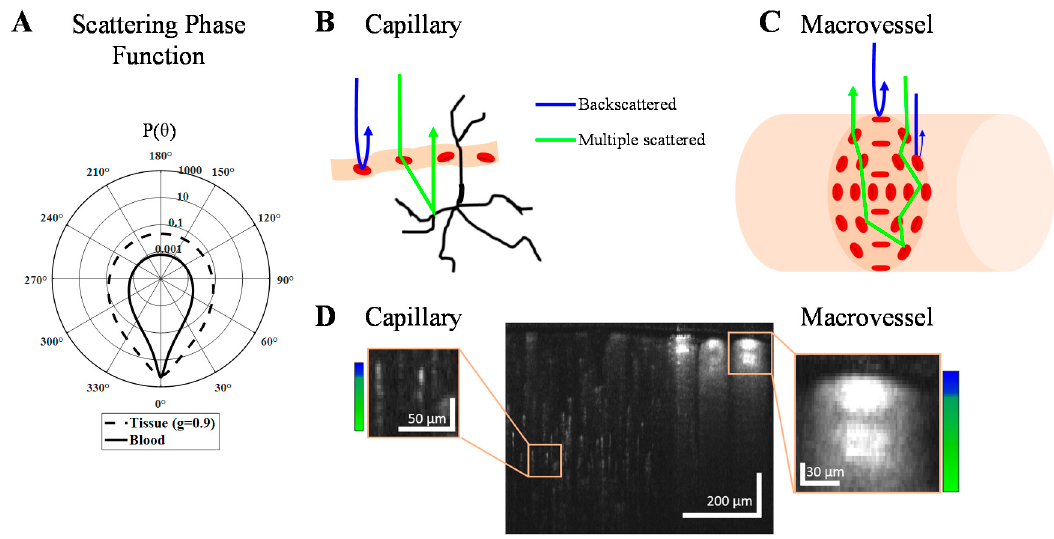
Figure 2. Single and multiple scattering in the OCTA of capillaries versus macrovasculature. ( A ) Blood has a high scattering anisotropy, leading to a high probability of detecting multiple scattered light paths; ( B ) For capillaries, dynamic RBC (red blood cell) forward scattering precedes or follows static tissue backscattering, which leads to “multiple scattering” tails; ( C ) In large vessels, the backscattering cross-section is determined by the shear-induced orientation of RBCs with their flat face parallel to the shear force. If the vessel lumen exceeds a scattering length, multiple intravascular dynamic scattering events (green) before detection are likely; ( D ) Cross-sectional OCT (Optical Coherence Tomography) angiogram of the mouse brain at 1300 nm (complex interframe subtraction method) with a qualitative colorbar showing the balance of backscattered light (blue) and multiple scattered light (green) in a capillary (left) and macrovessel (right).